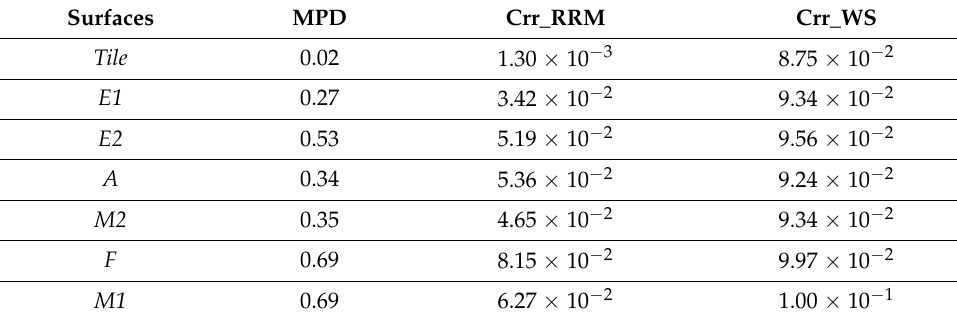
Table 2. Crr_RRM and Crr_WS of each test surface.